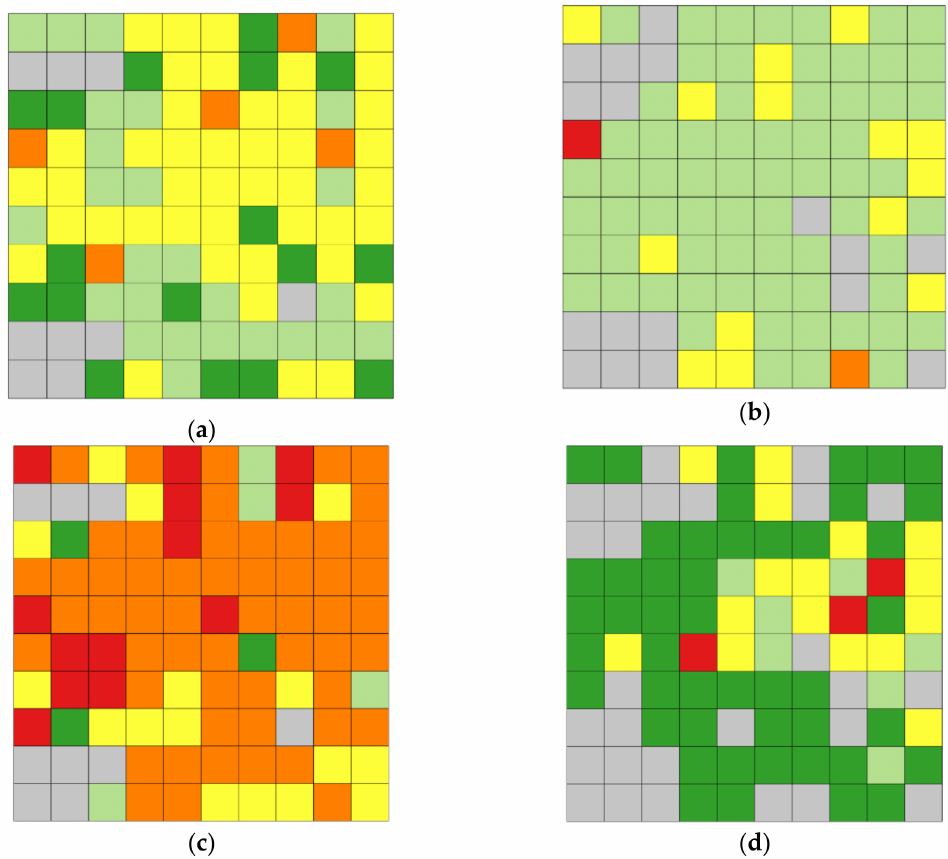
Figure 7. Level of connectivity for each basic field for k = 2 (200 m basic fields): ( a ) beta measure; ( b ) gamma measure; ( c ) eta measure; ( d ) four-way intersection